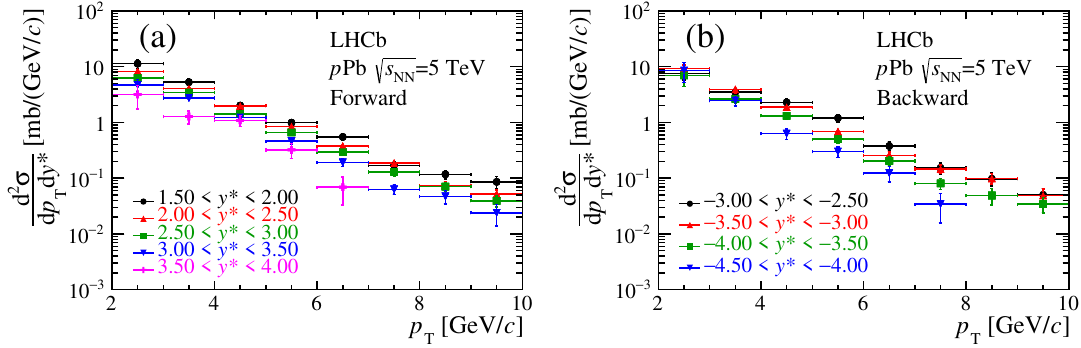
Figure 3 . Double-di(cid:11)erential cross-section of prompt (cid:3) + ward and (b) backward collision samples. The uncertainty represents the quadratic sum of the statistical and the systematic uncertainties.